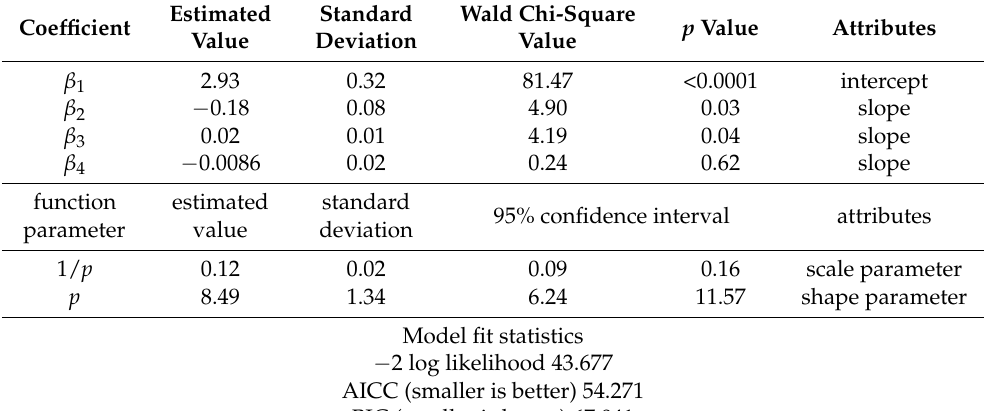
Table 3. Weibull function parameter estimates of State 1